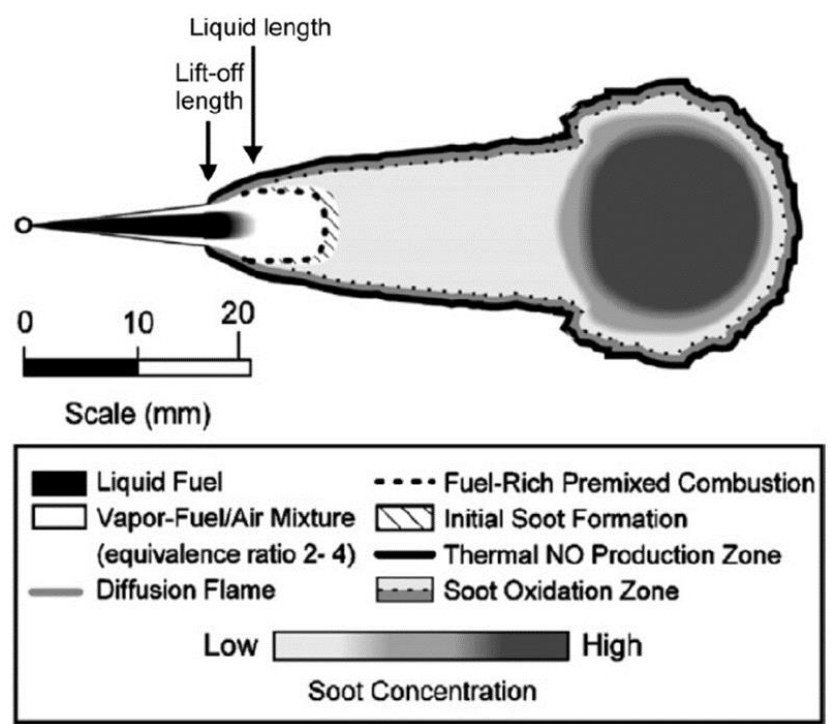
Figure 13. Illustration of soot formation in DIEs [58].